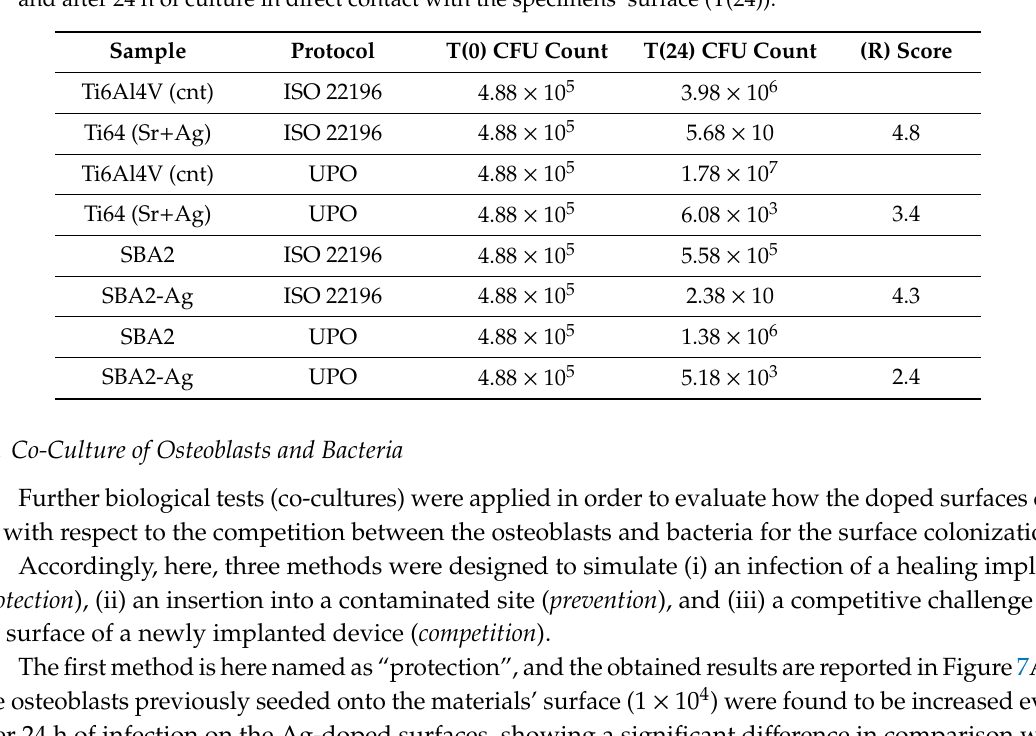
Table 2. R score values calculated by the colony-forming unit (CFU) count at the seeding day (T(O)) and after 24 h of culture in direct contact with the specimens’ surface